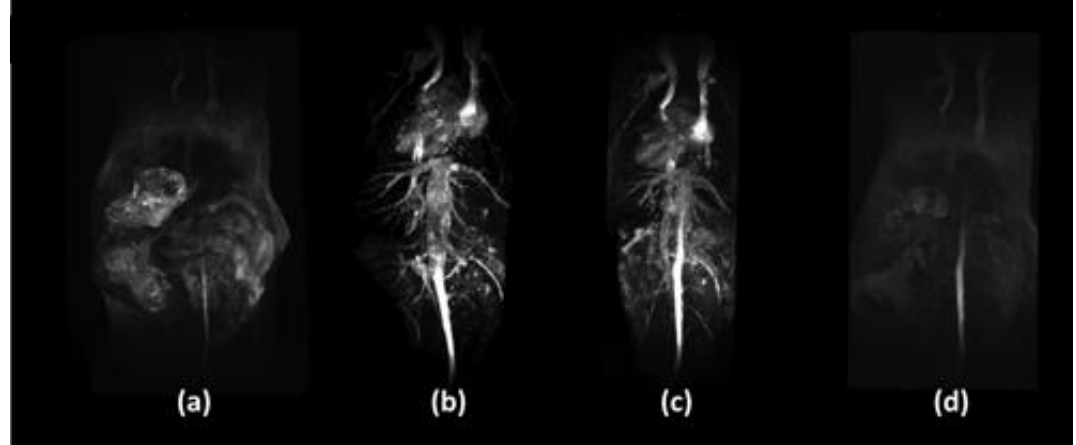
Figure 4. MRI ( T 1 -weighted imaging) body angiography in healthy mice, before ( a ) and after the intravenous injection, 0.04 mmol Fe kg − 1 , of Cu4-NPs at ( b ) 15 min ( c ) 30 min ( d ) 45 min. Reproduced with permission from [99].